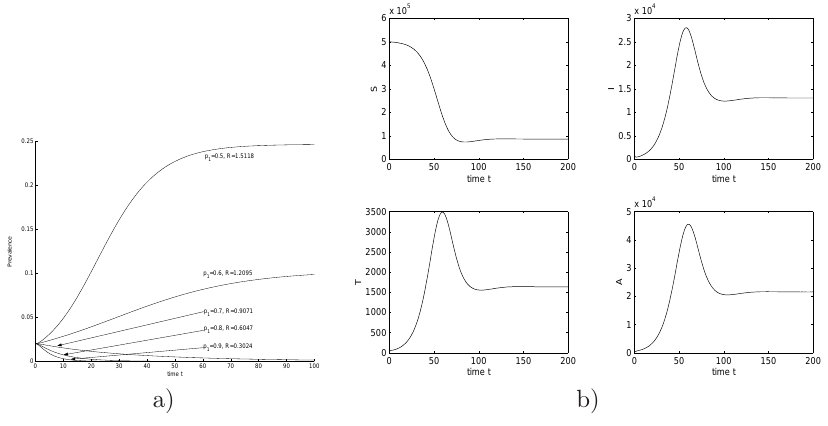
Figure 1. Results of simulations for the given parameter values µ = 0 . 02 , ν 1 = 0 . 6 , ν 2 = 0 . 7 , ǫ = 0 . 06 , b = 0 . 03 , σ = 0 . 09 , π = 10000 , d = 0 . 4 , β 1 = 0 . 004 , β 2 = 0 . 04 , β 3 = 0 . 3 , µ 0 = 0 . 001 , c = 4 , q = 0 . 01 , ρ = 0 : a) the prevalence curve for τ = 13 years , b) profiles of populations for p 1 = 0 . 5 , τ = 15 years